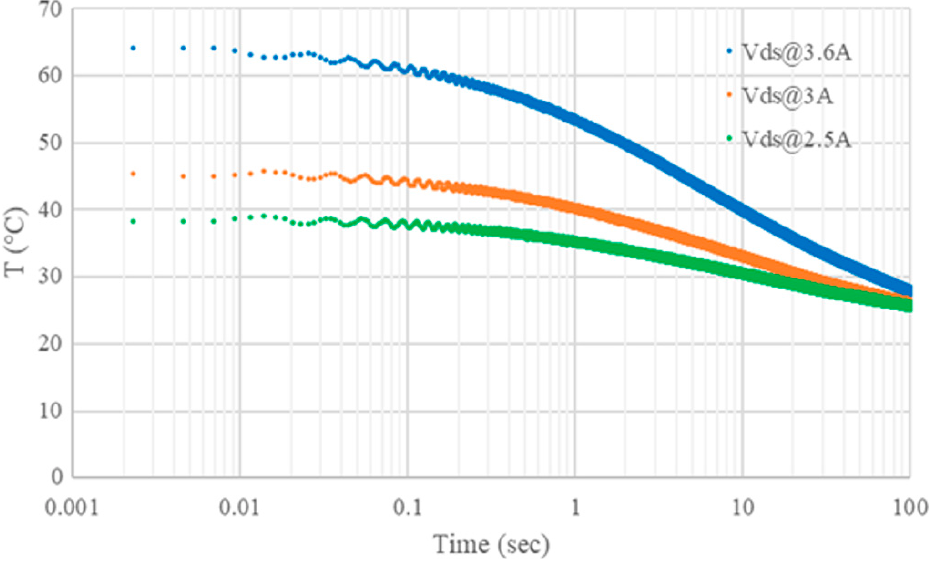
Figure 9. Cooling curves of V ds.